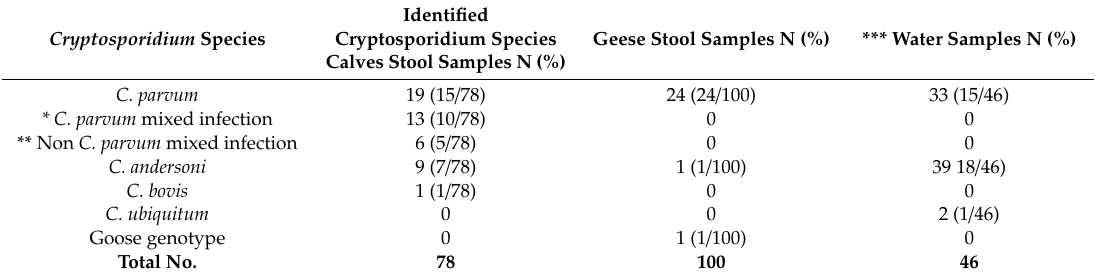
Table 4. Cryptosporidium species found in calf and goose samples on four Orkney farms and in water samples from two reservoirs.